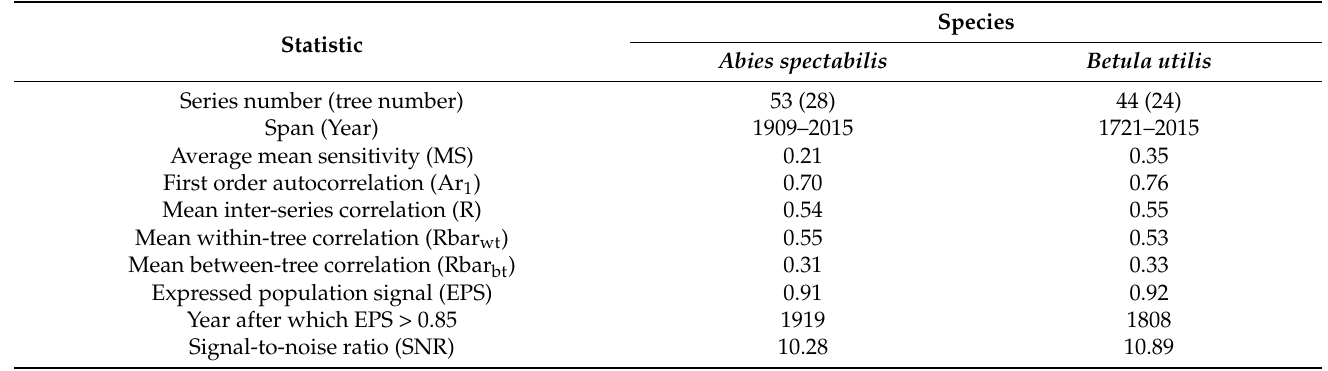
Table 1. Dendrochronological statistics for raw and standardized chronologies.